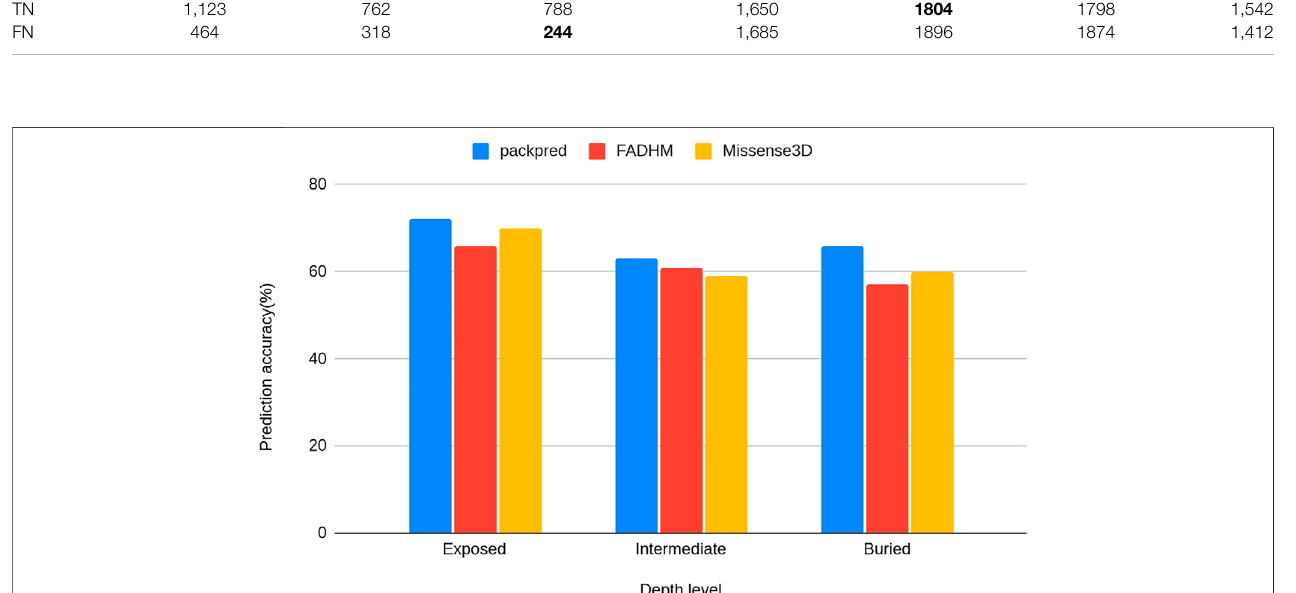
FIGURE 2 | Histograms of the prediction accuracy of Packpred, FADHM, and Missense3D at different depth levels (exposed to the solvent, intermediate, and buried).